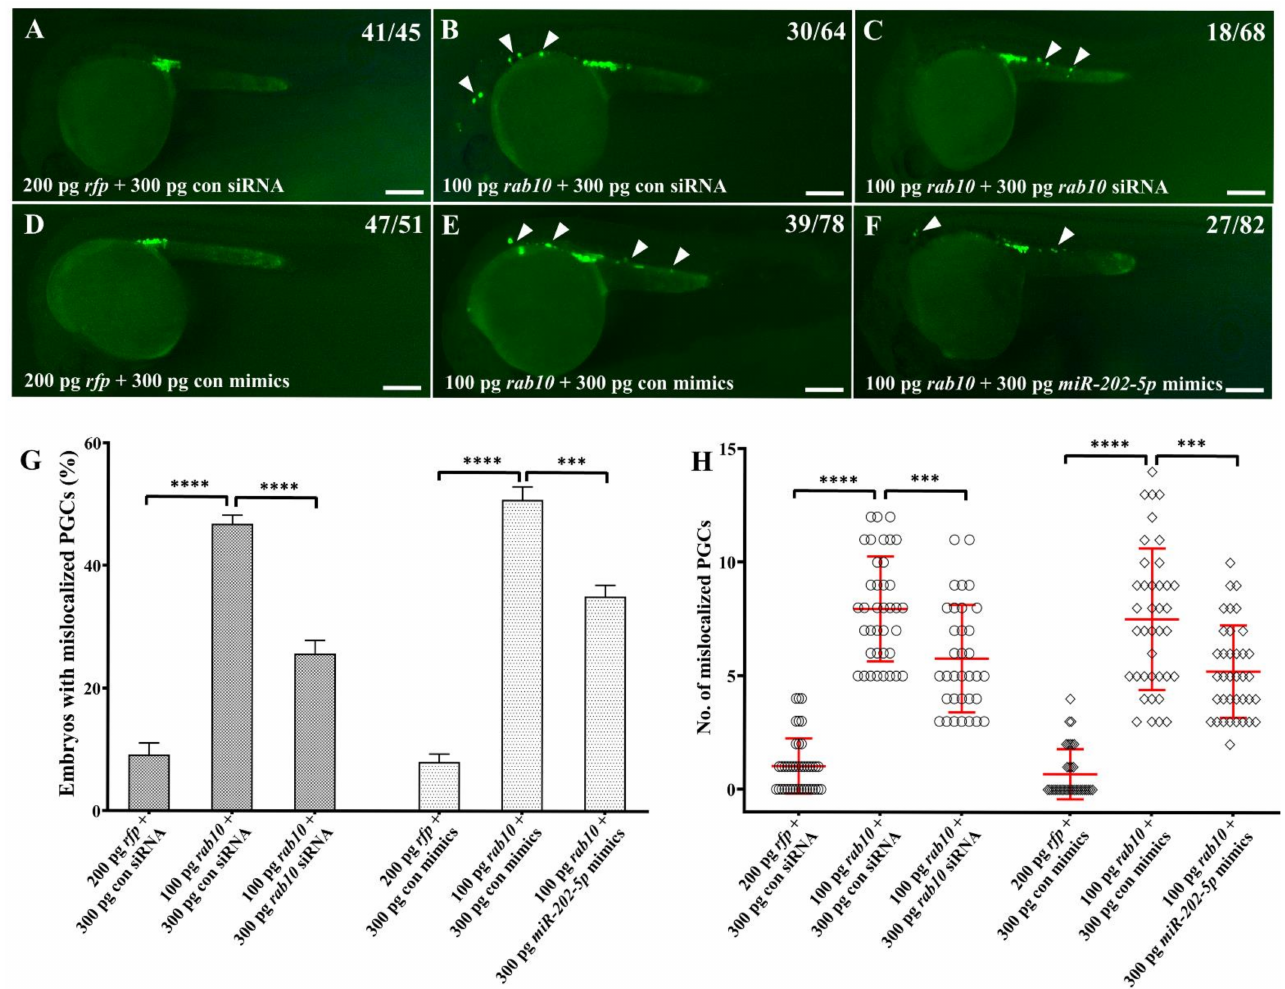
Figure 6. Overexpression of miR-202-5p partially rescues PGC migration in embryos overexpressing rab10 . ( A – F ) Repre- sentative images of PGCs in embryos injected with 200 pg rfp mRNA and 300 pg control siRNA or control mimics ( A , D ), 100 pg rab10 mRNA and 300 pg control siRNA or control mimics ( B , E ), 100 pg rab10 mRNA and 300 pg rab10 siRNA or miR-202-5p mimics ( C , F ). Arrowheads indicate mislocalized PGCs. The corresponding phenotypes in different groups of embryos were shown in the upper right of the panels ( A – F ). ( G ) The percentage of embryos with mislocalized PGCs in ( A – F ). ( H ) The number of mislocalized PGCs in each embryo in ( A – F ). ( G , H ) The results were representative of more than three independent experiments in triplicate. The average number of mislocalized PGCs were showed in red line by mean ± sd. *** p < 0.001, **** p < 0.0001. Scale bar, 100 µ